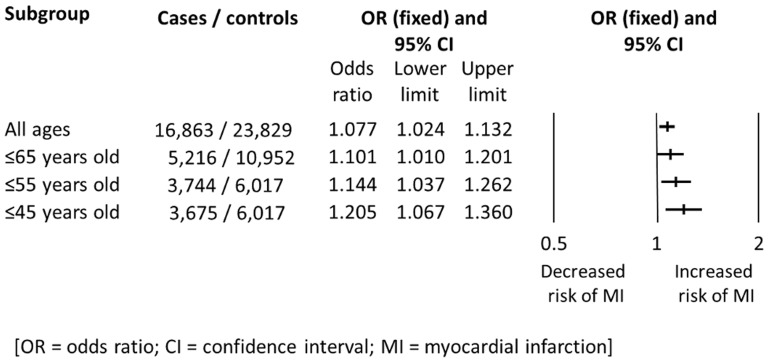
Summary of subgroup analyses based on age at first event.Analysis is of the PlA1/A1 versus PlA1/A2+PlA2/A2 genotype.